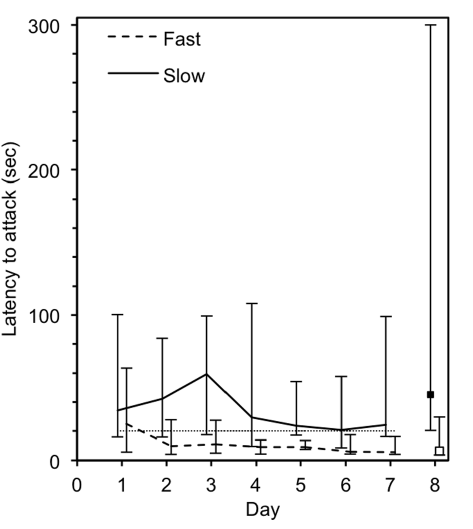
Figure 1. The median latencies over the course of the 8 days of the experiment for slow birds (solid line and filled symbol) and fast birds (hashed line and unfilled symbol). The bars represent the 10 th and 90 th percentiles. It is interesting to note that the latencies for the fast birds reach an asymptote on day 2 whereas slow birds reach their asymptote on day 3 of the experiment.